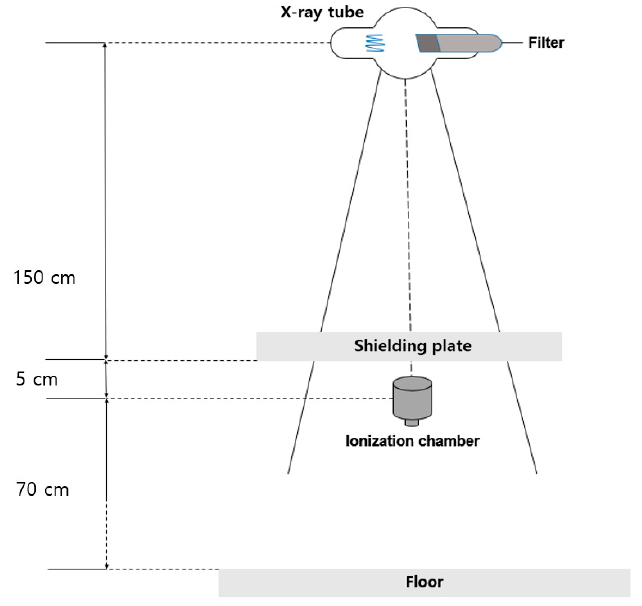
Figure 1. Schematic of the radiation-shielding measurement.